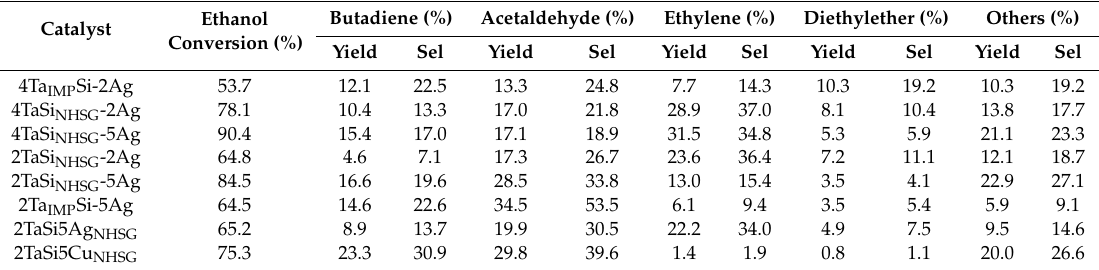
Table 2. Catalytic conversion of ethanol, yield and selectivity for butadiene and by-products; Reaction conditions: T = 355 ◦ C, WHSV = 1.10 h − 1